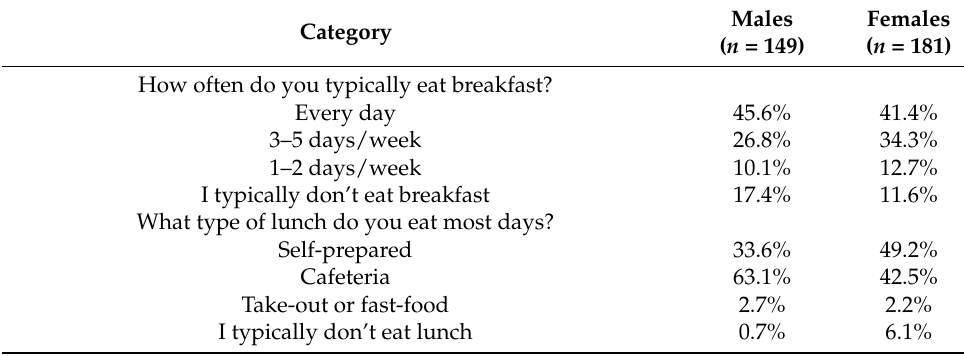
Table 3. General dietary habits of